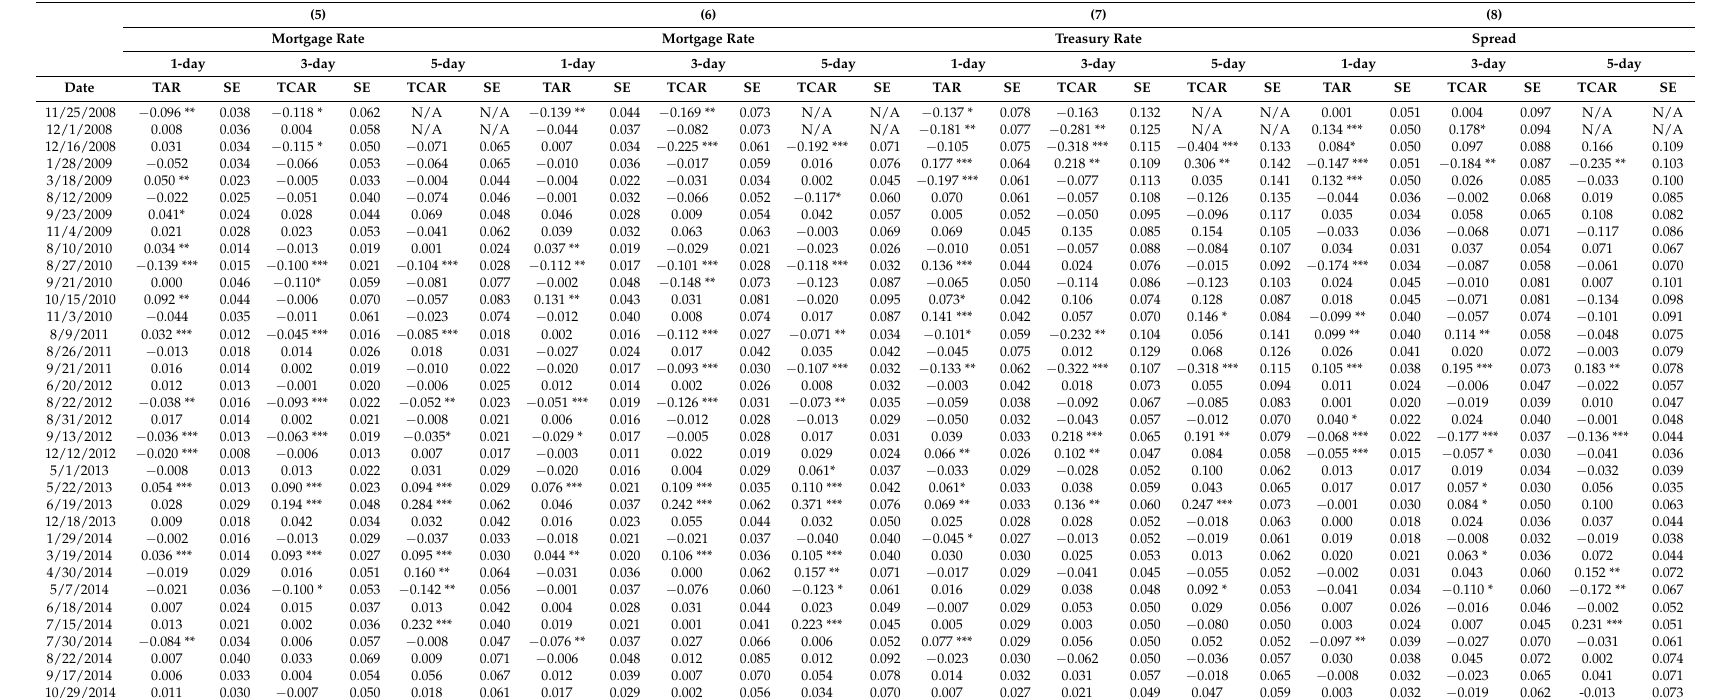
Table 4. Delayed effects of QE